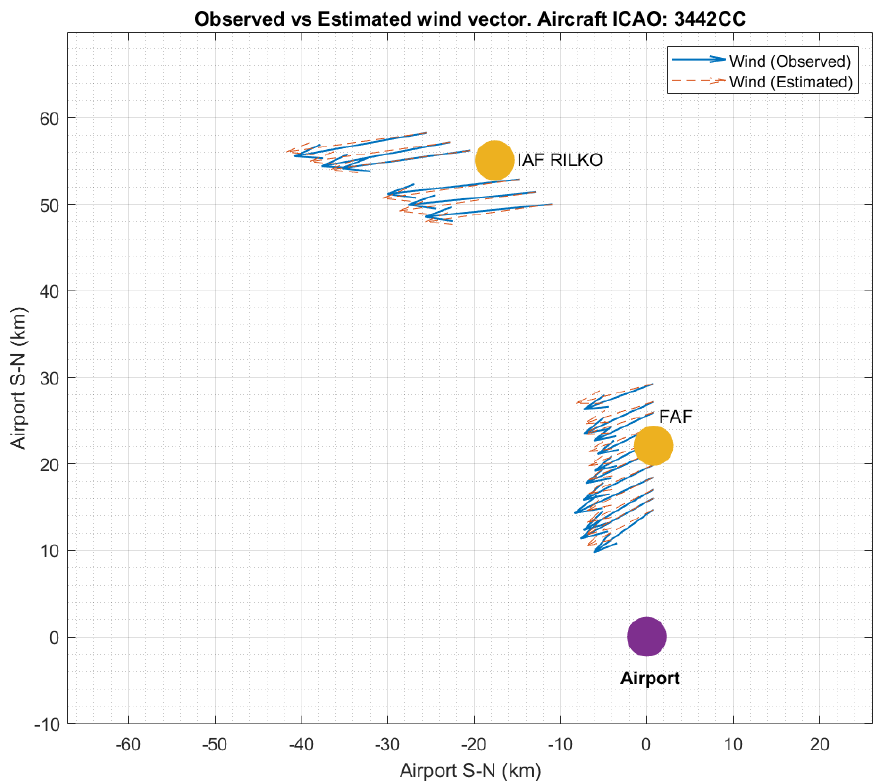
Figure 7. Comparison of estimated and observed wind vector when aircraft 3442CC flies through the waypoints RILKO IAF and FAF. The east-west and south-north directions are represented in the x and y axes,